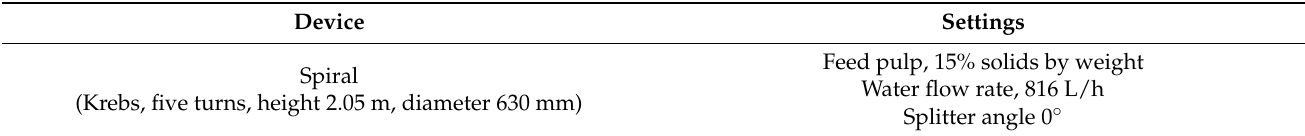
Table 3. Gravity concentration devices and their used settings.